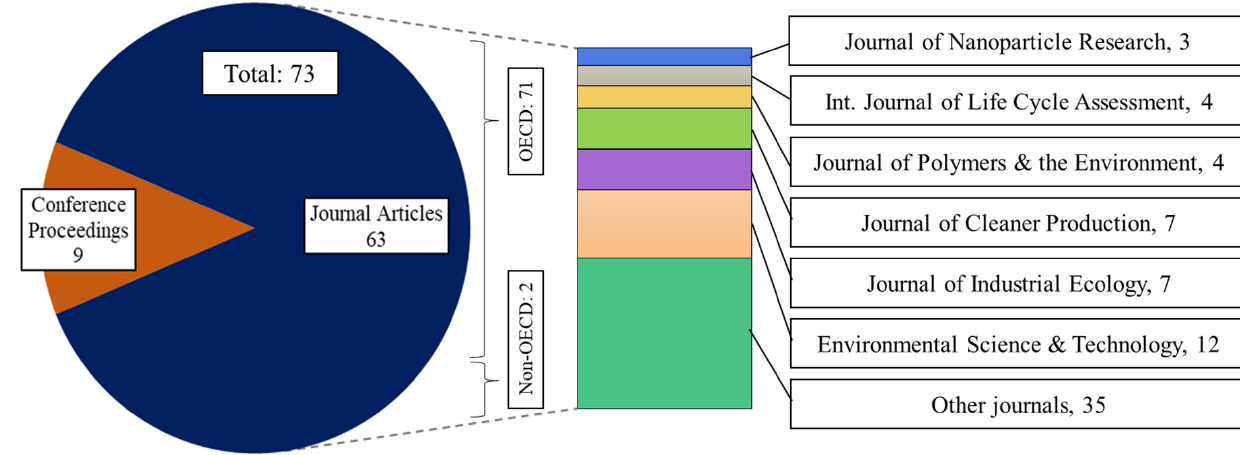
Figure 5. Distribution of the publications based on journals.